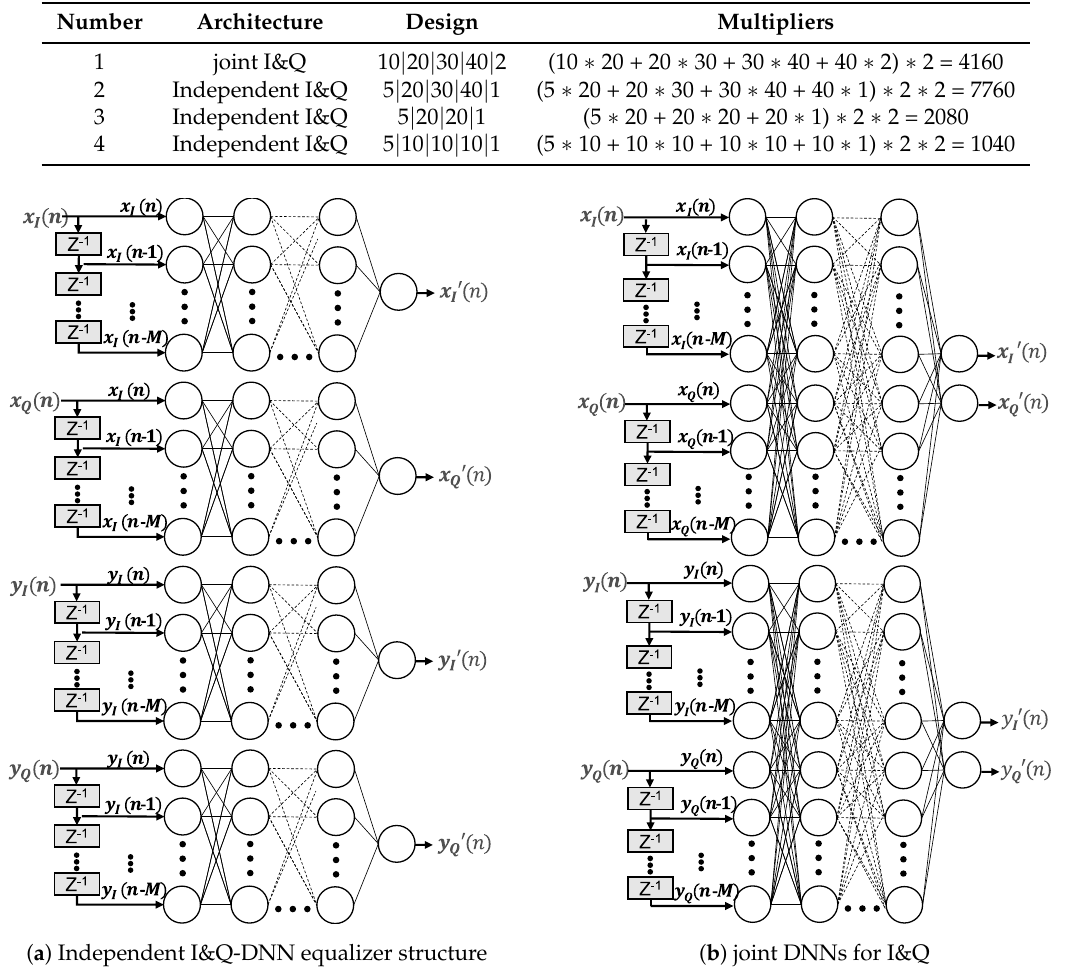
Figure 9. Deep Neural Network Equalizer